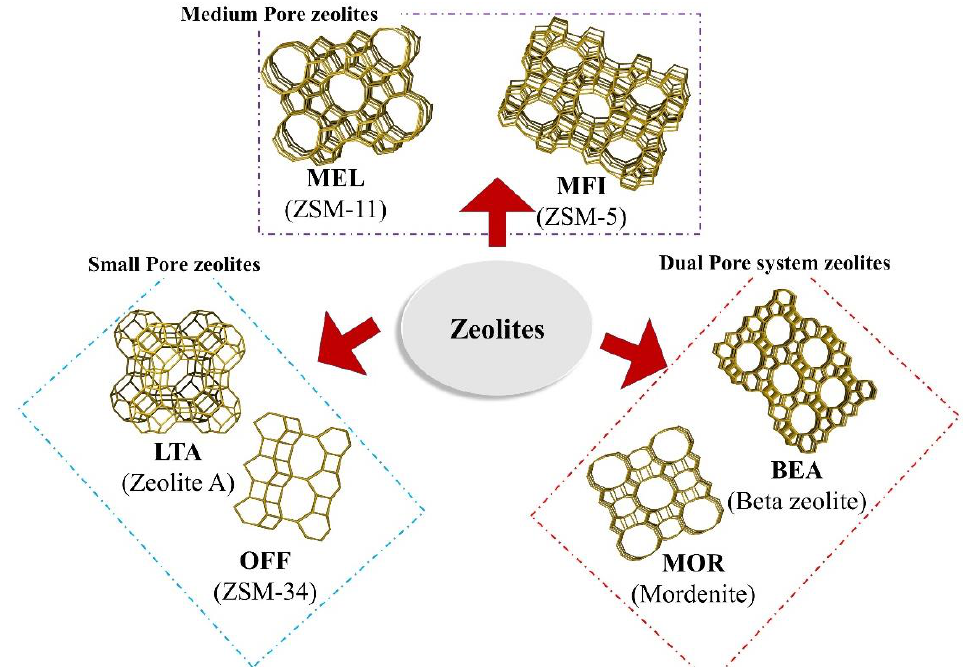
Figure 5. Classification of zeolites according to the pore system. Medium pore zeolites: MEL (Zeolite Socony Mobil-eleven, ZSM-11) and MFI (Zeolite Socony Mobil-five, ZSM-5). Dual pore system zeolites: BEA (Zeolite Beta polymorph A) and MOR (Mordenite). Small pore zeolites: LTA (Linde Type A), Zeolite A, OFF (Offretite) and ZSM-34 (Zeolite Socony